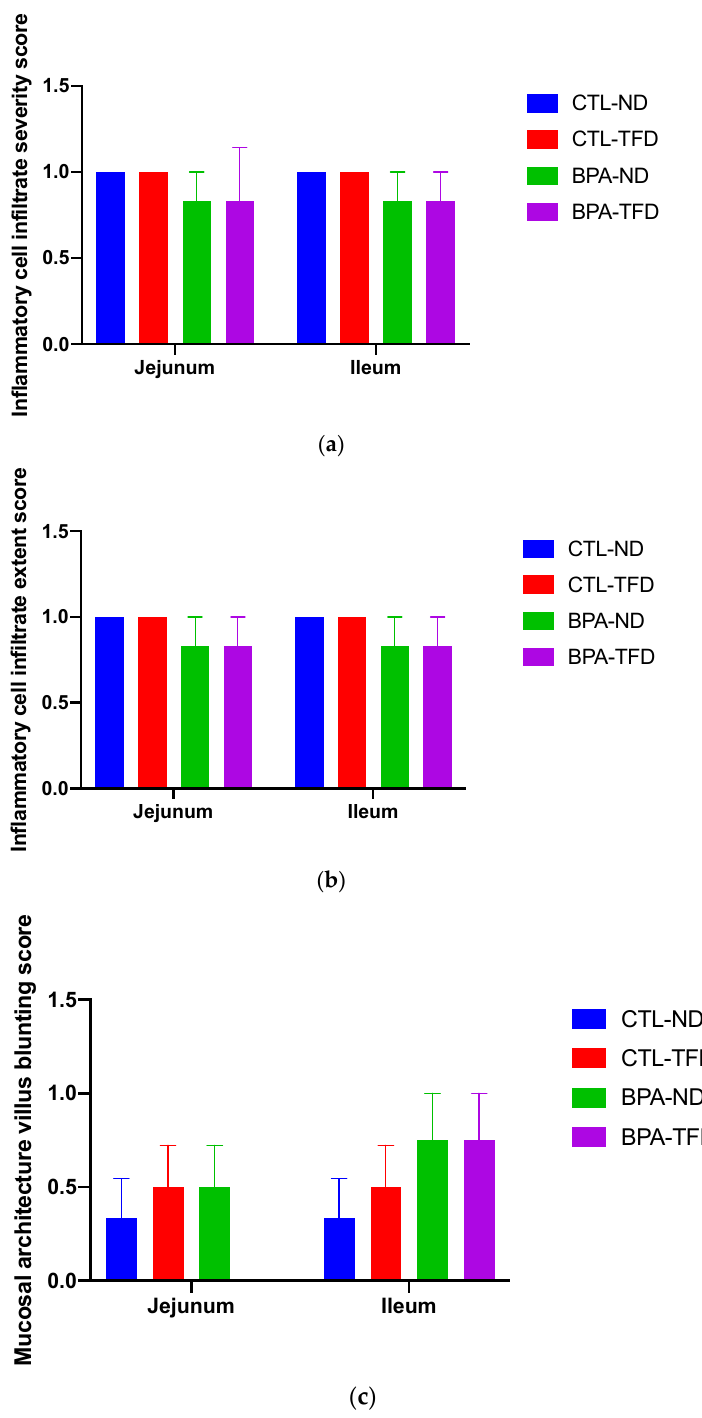
Figure 6. Histomorphological scores of the jejunum and ileum sections from adult offspring. There were three parameters considered during the assessment: (i) leukocyte infiltration, which was divided into the density in the lamina propria area ( a ) and its expansion ( b ), as well as changes in (ii) the epithelium and (iii) the mucosal architecture [38]. Only villous blunting ( c ) was observed under the mucosal architecture category, while other changes such as ulceration, granulation tissue, irregular crypts, and crypt loss were not detected. Similarly, no epithelial changes were observed in all samples except for the jejunum section of one BPA-TFD offspring, which displayed minimal goblet cell loss. The villus blunting score for BPA-TFD offspring’s jejunum was not shown in ( c ) because the value is zero. The score value 1 indicates minimal changes ( n = 6/group).